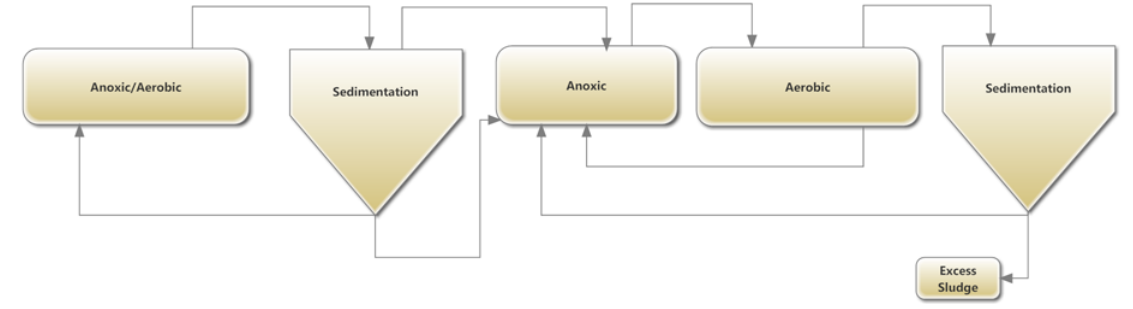
Figure 1. Slaughterhouse wastewater treatment plant (WWTP ‐ 1)